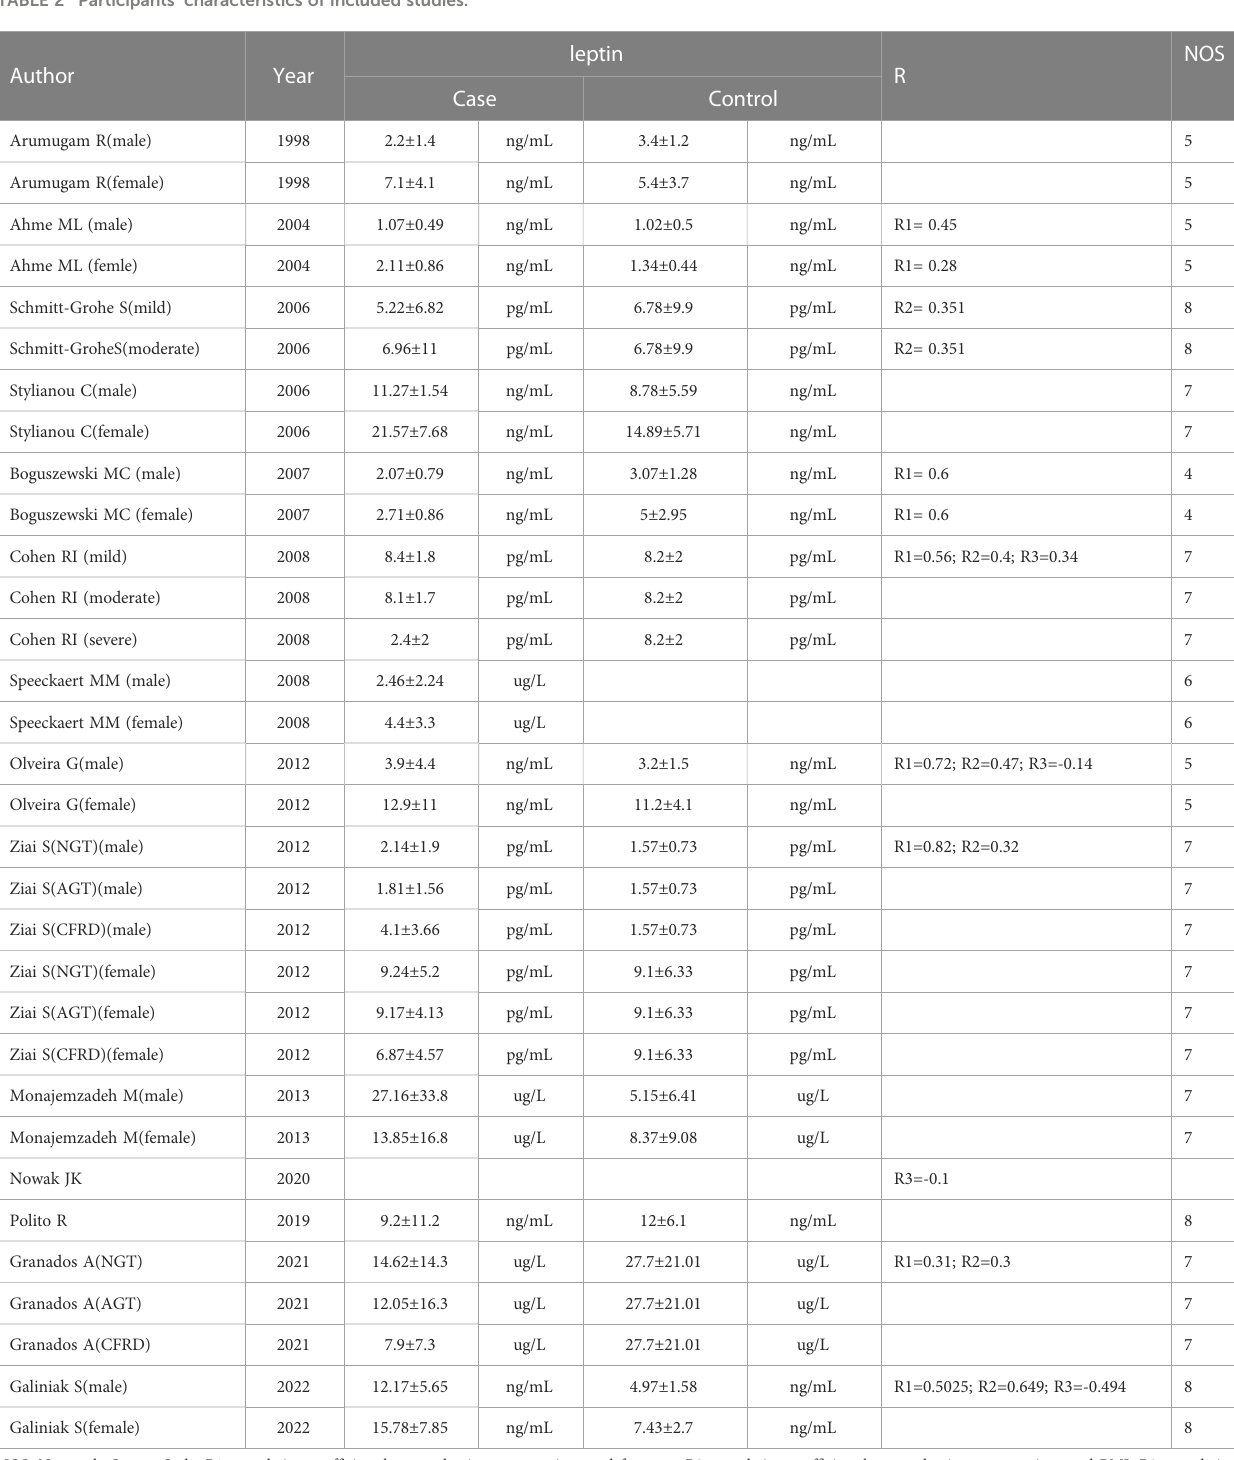
TABLE 2 Participants ’ characteristics of included